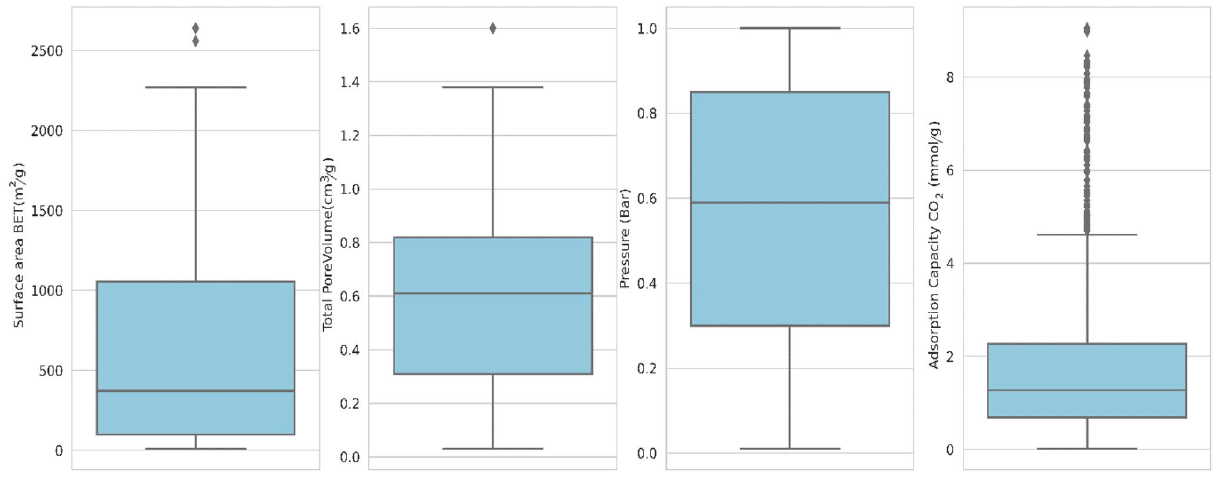
Figure 2. Boxplot of